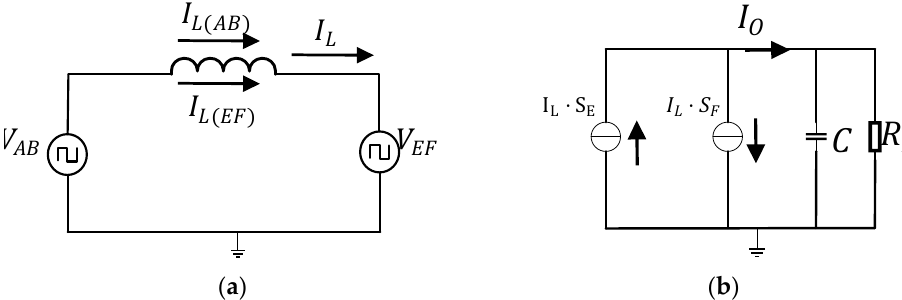
Figure 3. Inductor current decomposition: ( a ) equivalent circuit using to the superposition principle; ( b ) equivalent circuit for the analysis of average output current.